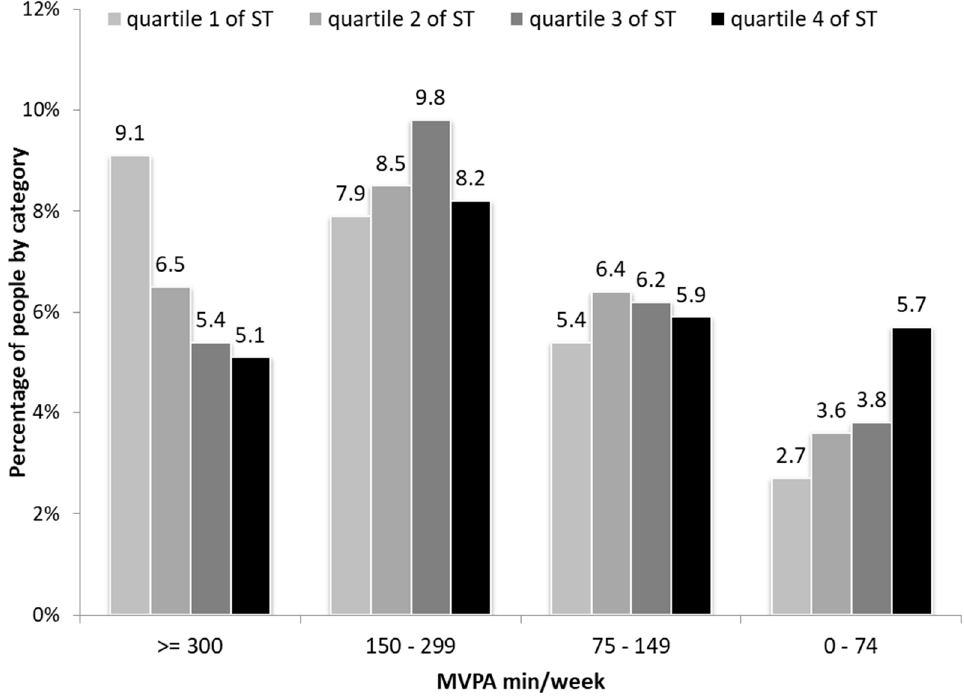
Figure 1. Percentage of sedentary time and moderate-to-vigorous physical activity according to joint categories.